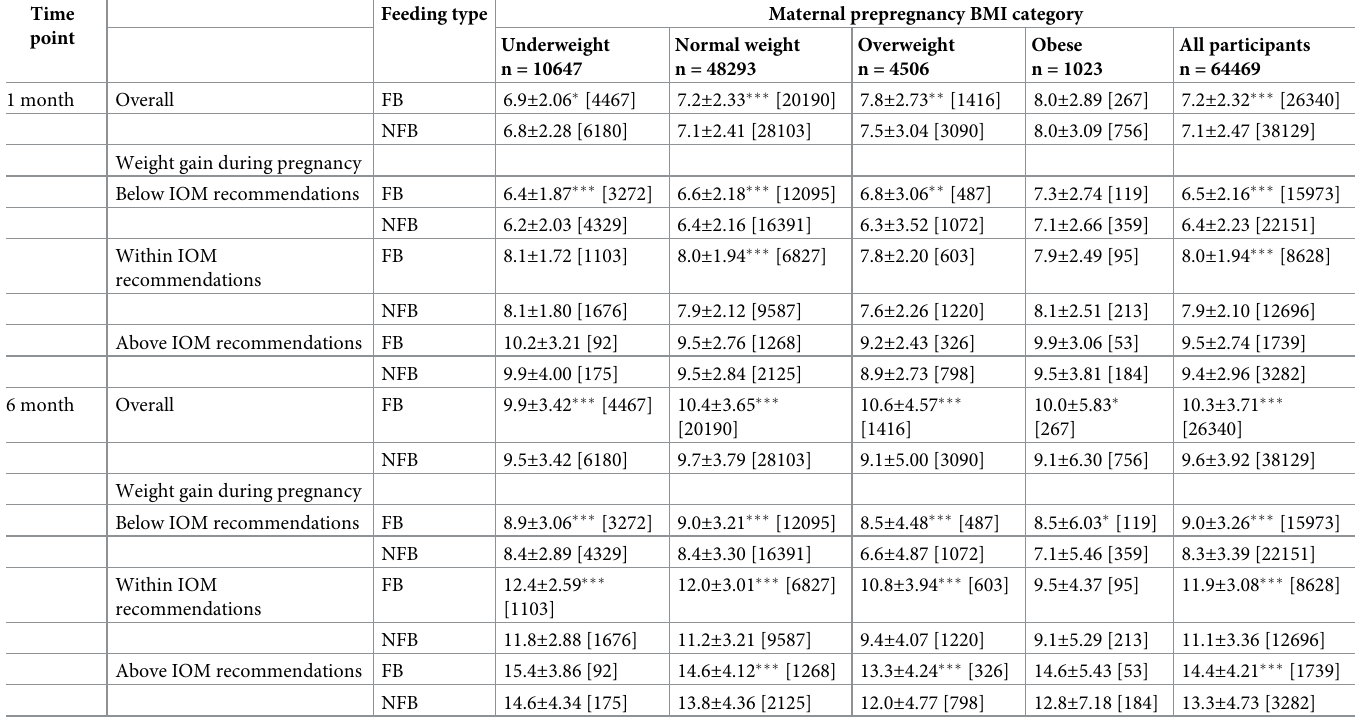
Table 2. Weight loss (kg) from delivery at 1 and 6 months